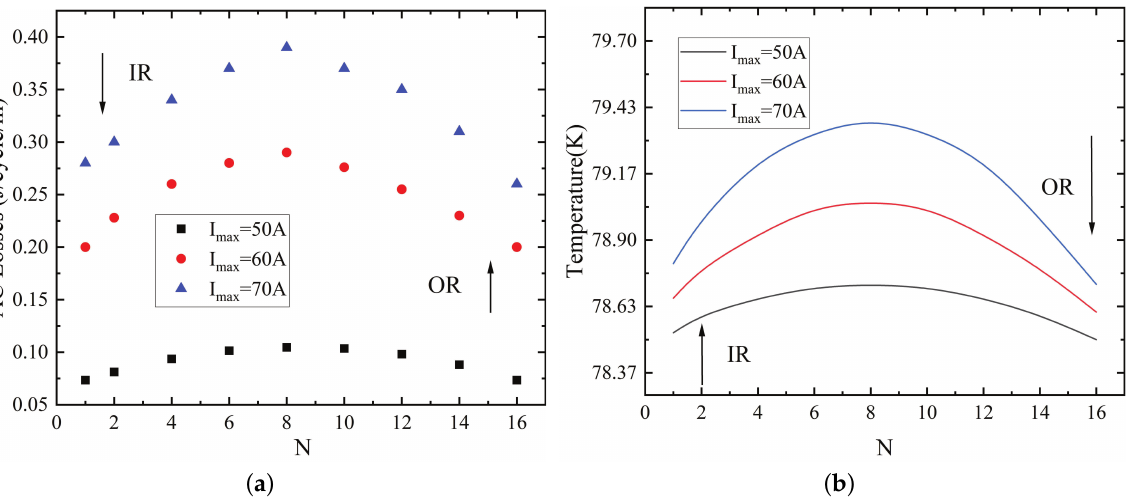
Figure 4. Loss and temperature distribution of 16-turn coil under different peak currents. ( a ) Loss distribution at different peak currents. ( b ) Temperature distribution at different peak